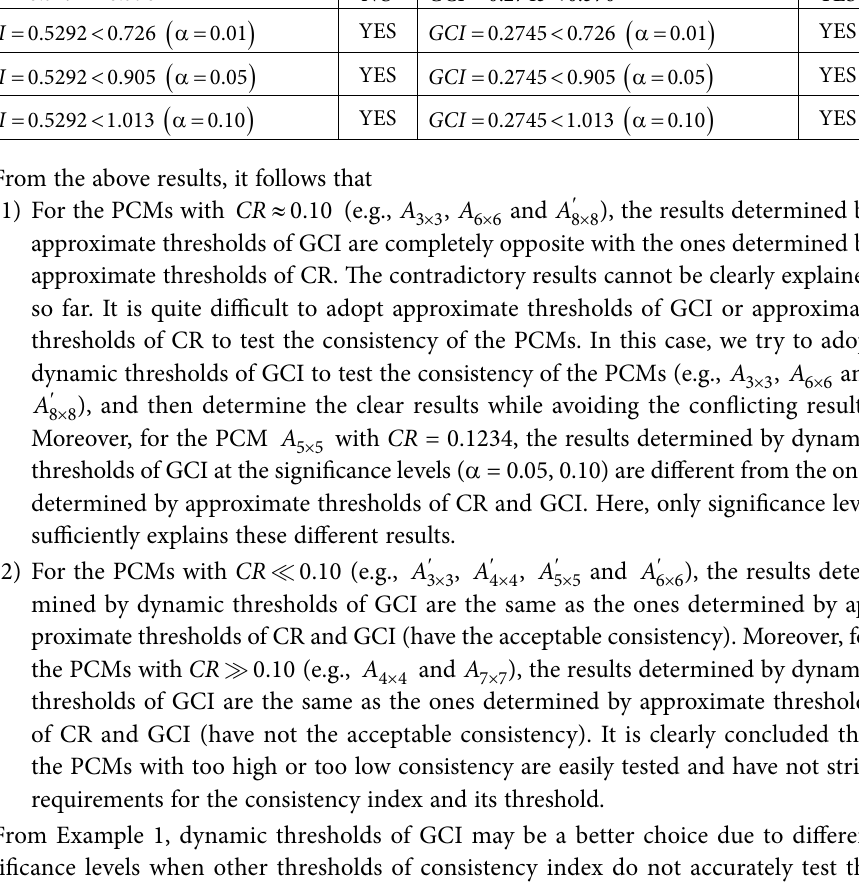
Table 9. The corresponding results for two 8-order PCMs = > 0.1691 0.10